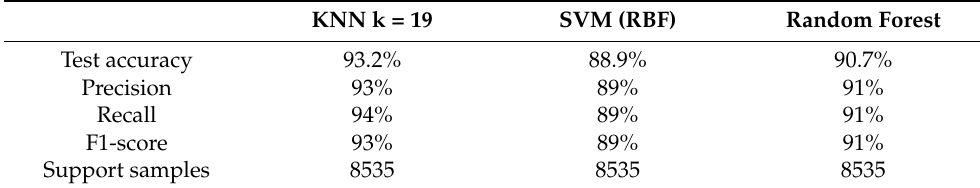
Table 5. Evaluation metrics for KNN and SVM after dimensional reduction.